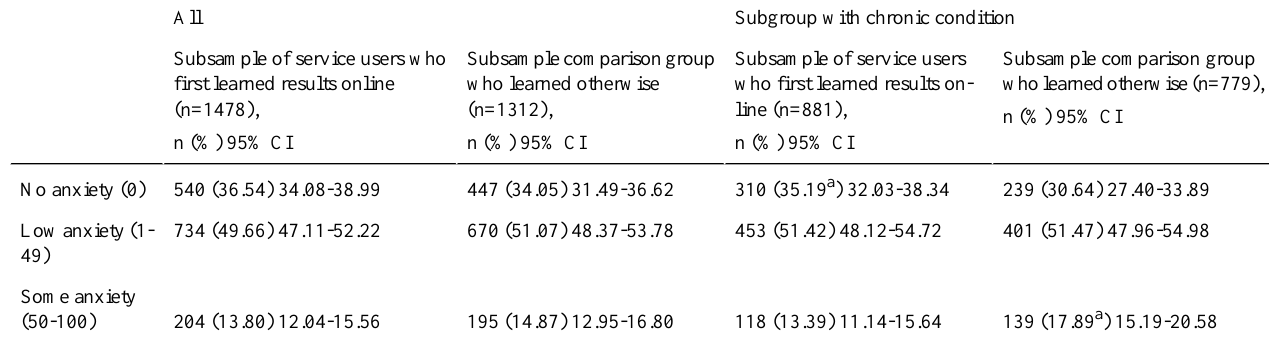
Table 5. Anxiety after receiving lab test results.